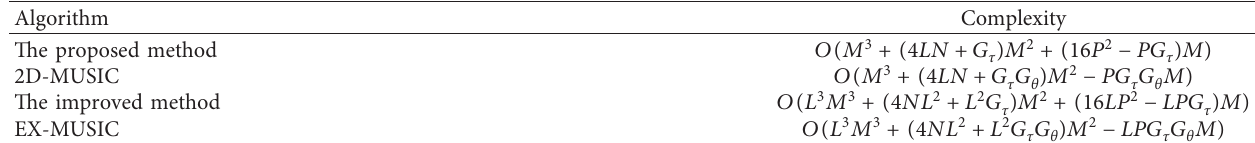
Table 1: Computational complexity comparison.